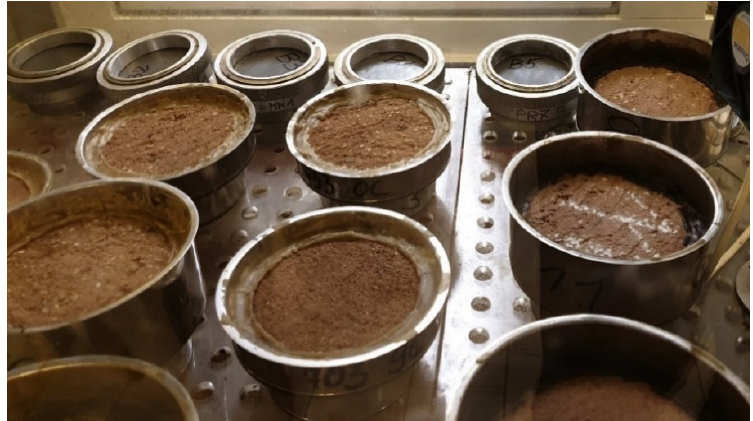
Figure 7. Vapour permeability test.